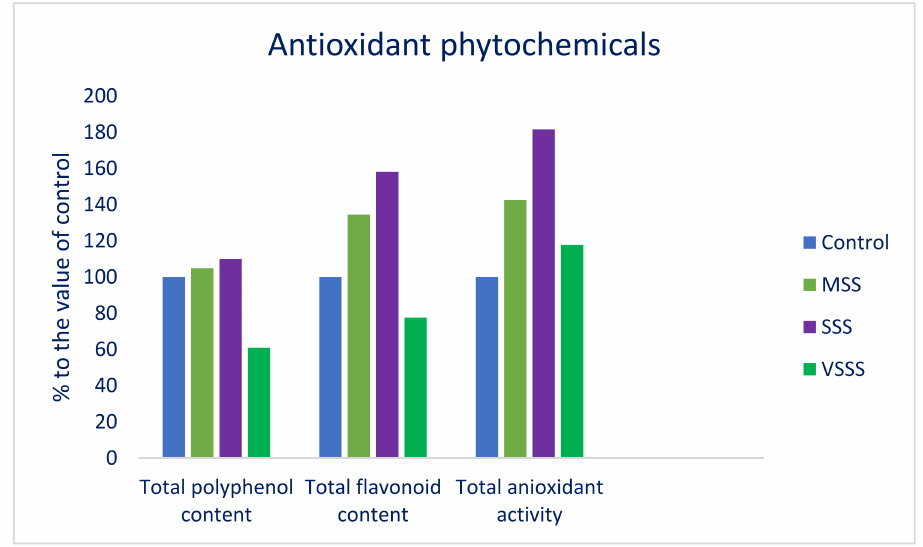
Figure 4. Variations in antioxidant phytochemicals (% to the value of control) under four salinity levels: Control (no saline water); MSS = medium salinity stress (50 mM NaCl); SSS = severe salinity stress (100 mM NaCl); VSSS = very severe salinity stress (150 mM NaCl), in four selected A. lividus genotypes; ( n =